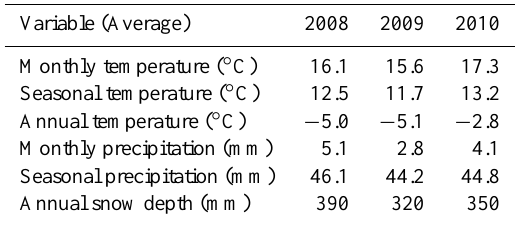
Table 2. Monthly (July), seasonal (May, June, July) and annual av- erage of climatic variables during the 3years of the study (2008, 2009 and